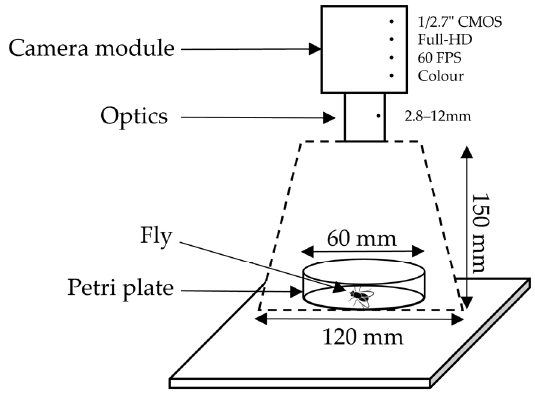
Figure 1. Experimental setup for images acquisition with the camera pointing to the fly inside a petri dish . petri